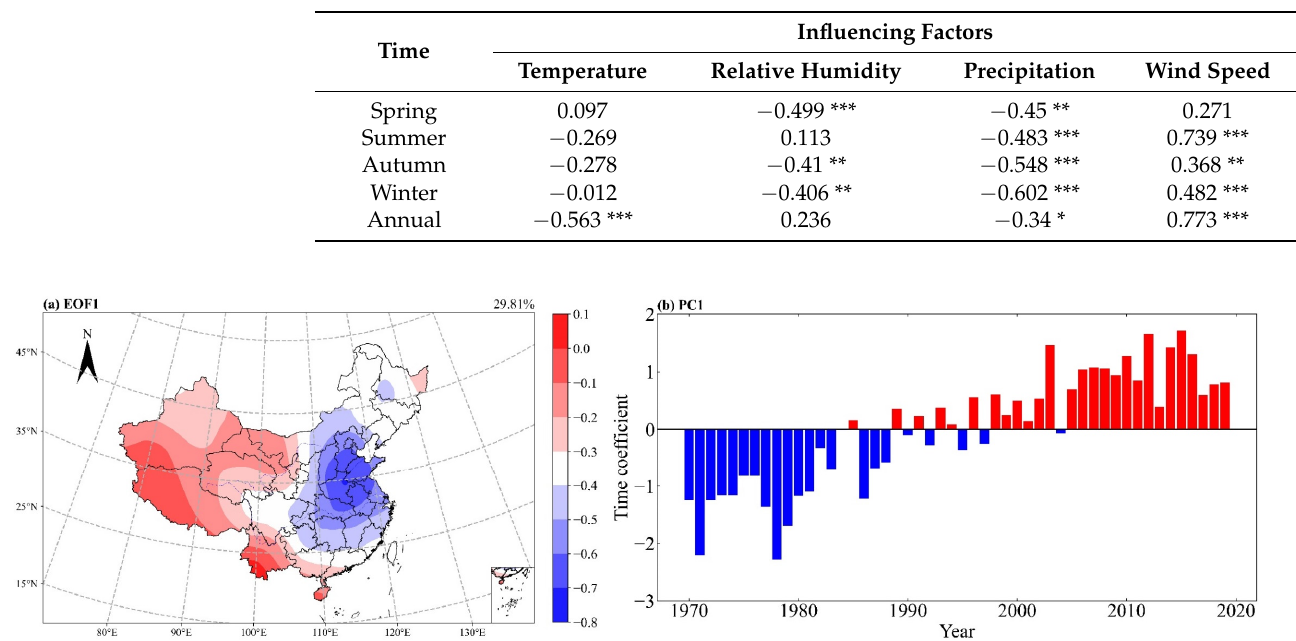
Figure 6. Spatial distribution ( a ) and time coefficient ( b ) of the first mode. The variance contribution rate of the eigenvectors of the second mode is 8.93% (Table 2). The eigenvector space of the second mode is oppositely distributed in the north–south